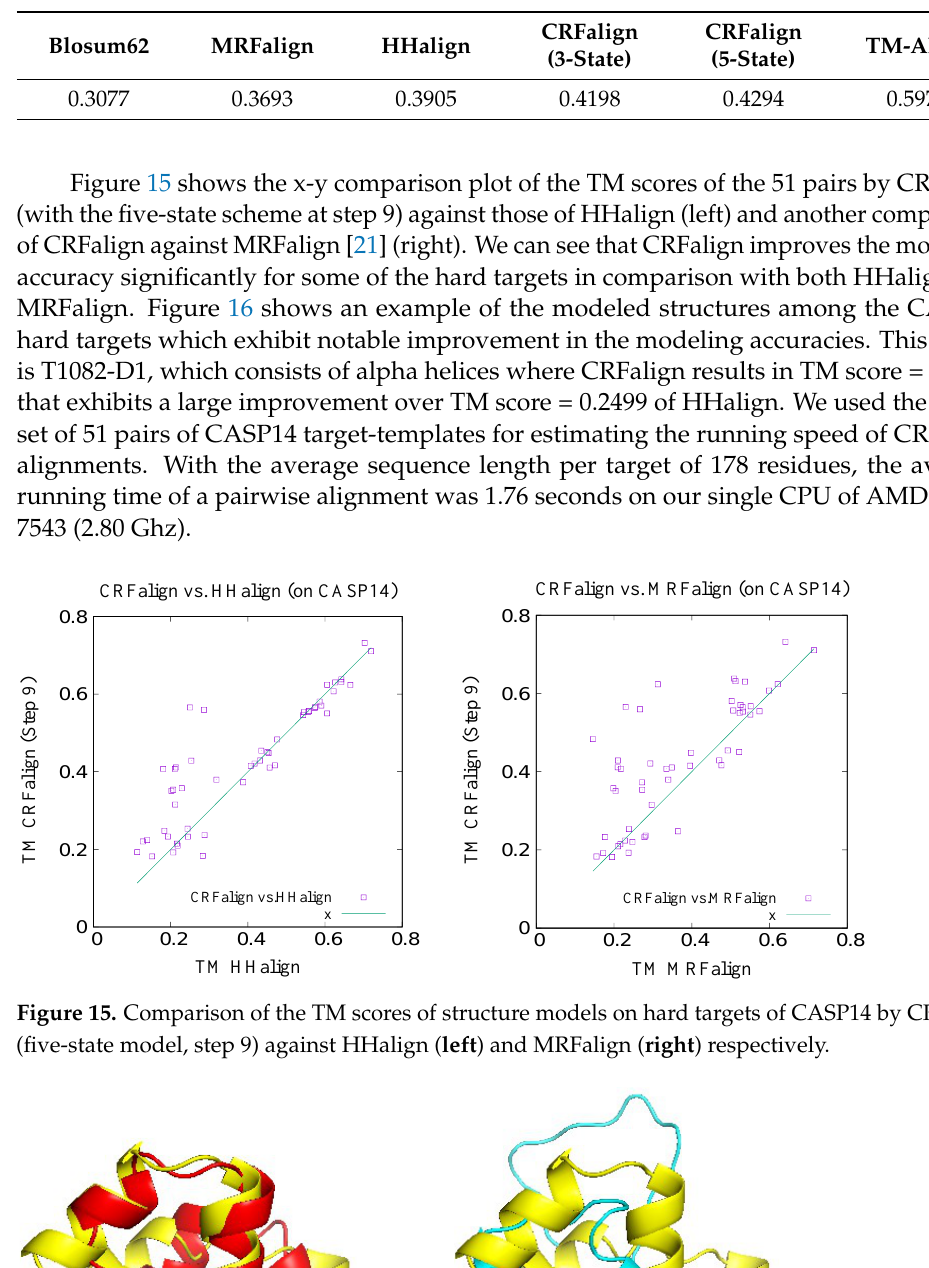
Table 5. Average TM score of models by various alignment methods on 51 pairs involving the CASP14 hard targets together with the maximal TM score (of TM-align).